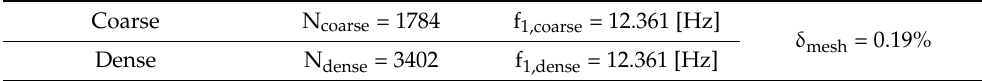
Table 4. The number of elements used and the first eigenfrequencies are shown here. The error is less than 1% therefore the simulation is independent from the mesh.